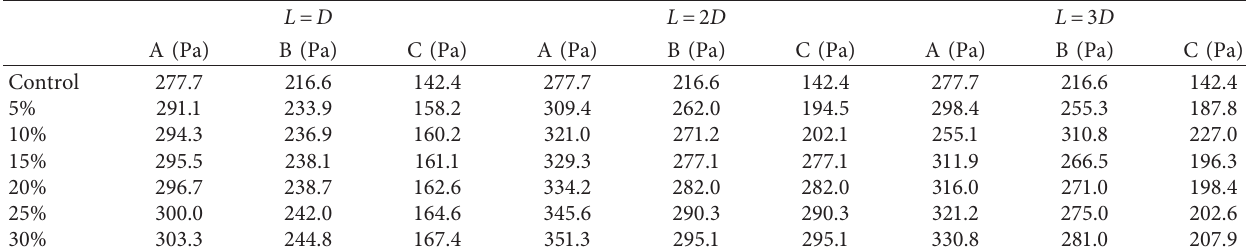
Table 4: The average pressure at different locations (Groups A, B, and